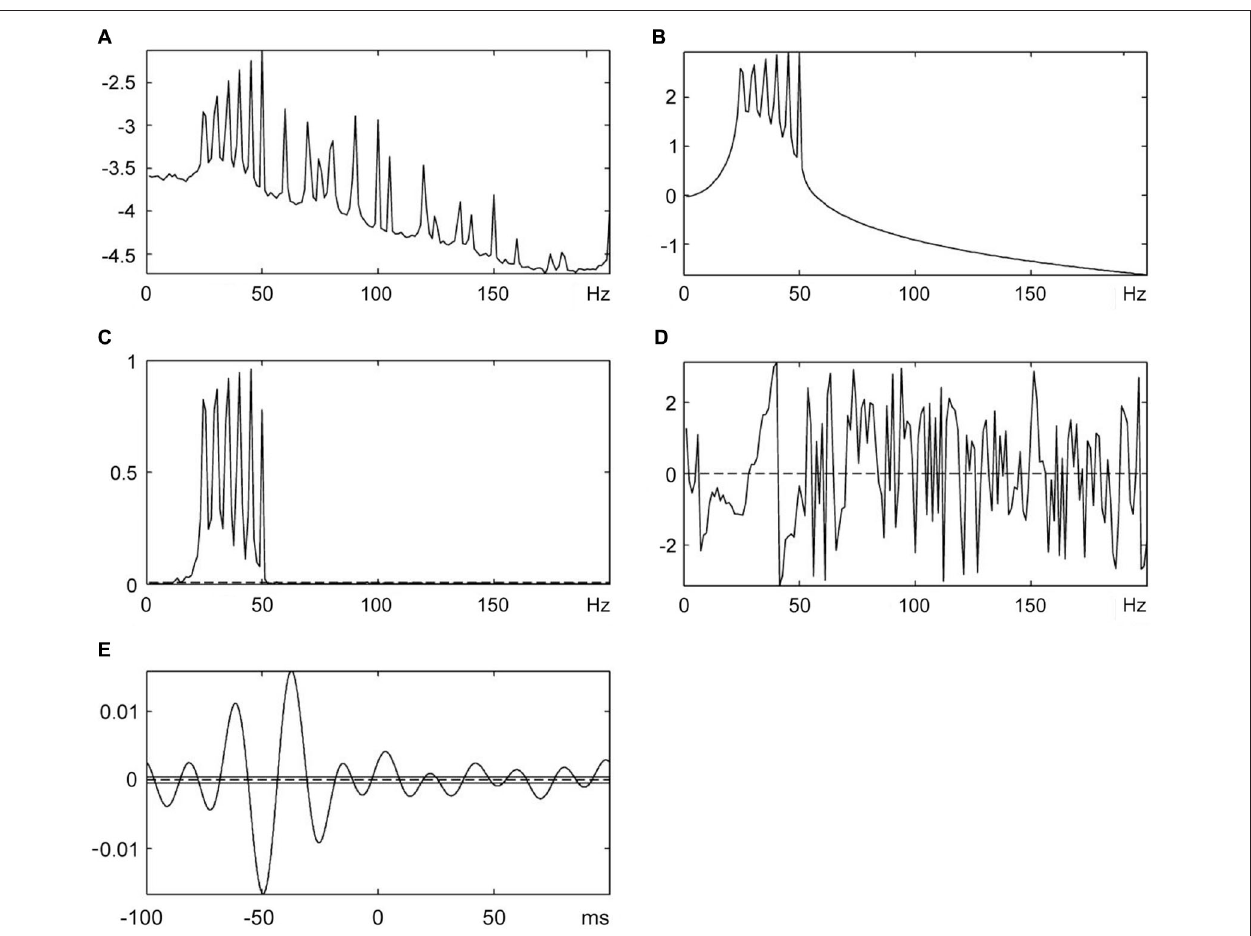
FIGURE 5 | The cumulant density analysis for Force-MMU data. (A) Spectral analysis of SEMG data, (B) Spectral analysis of force (vibration stimuli), (C) The coherence analysis shows a significant correlation between SEMG and vibration signals, (D) Phase analysis and (E) Lag time between SEMG and vibration stimuli.